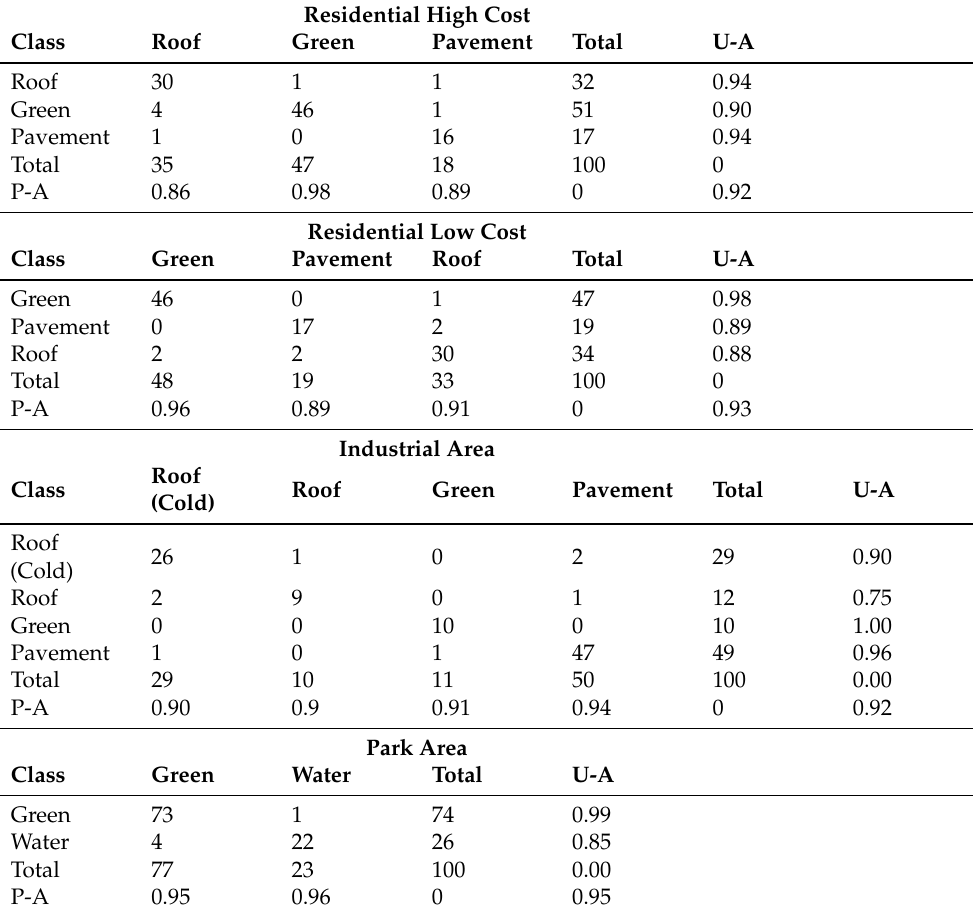
Table 5. Confusion matrix for each